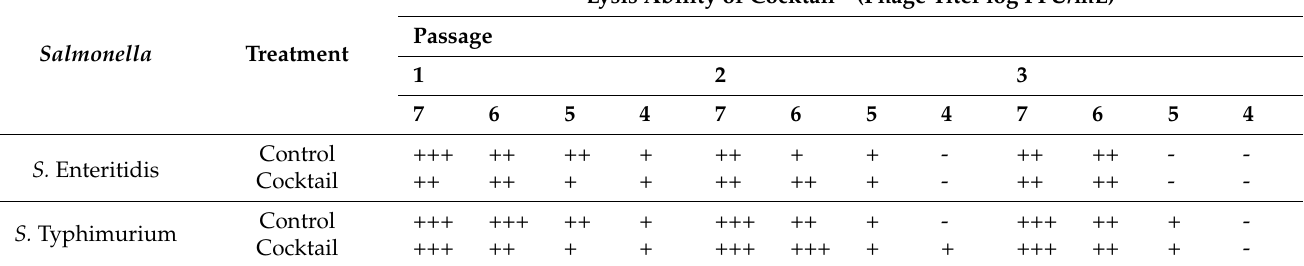
Table 3. Phage lysis on Salmonella reference serovars upon three-passage treatments of a phage